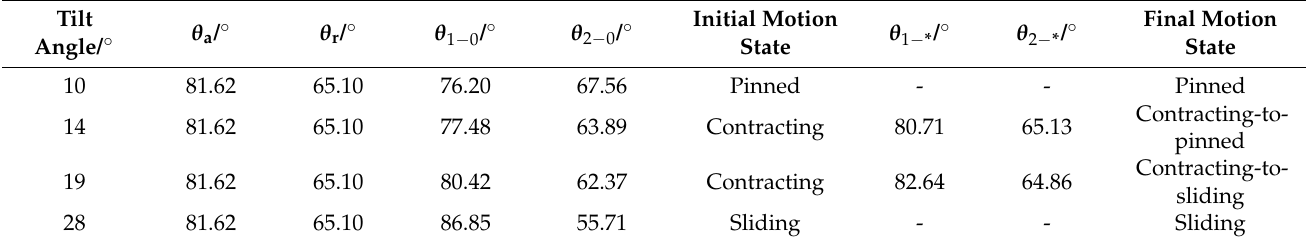
Table 3. Numerical results and motion state predictions of droplets on the inclined, smooth PMMA surface a .